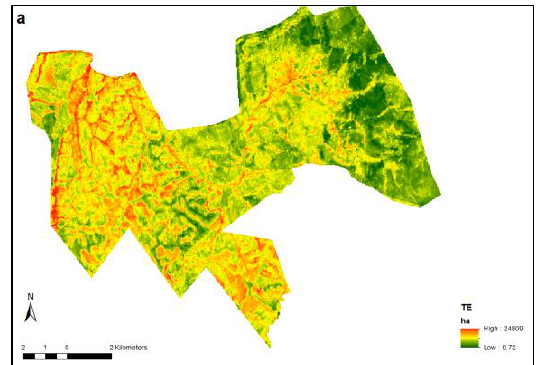
Figure 4. (a) Predicted TE map